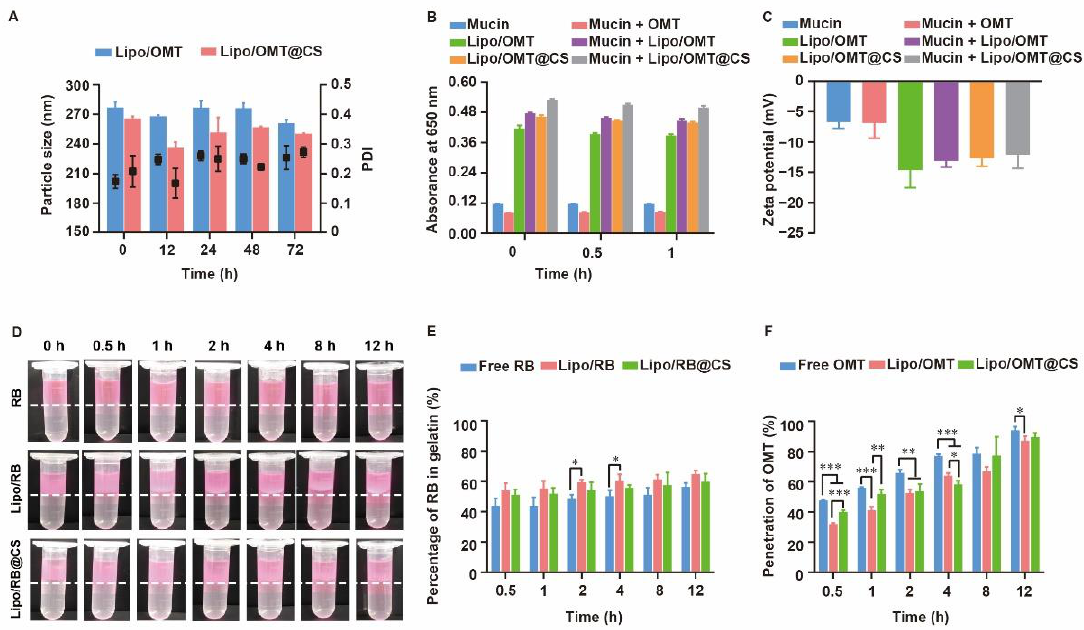
Figure 4. Stability and penetration capability of OMT/RB liposomal preparations in mucin media. ( A ) Particle size of OMT liposomal preparations in mucin. ( B ) Absorbance at 650 nm and ( C ) zeta potential of OMT liposomal preparations alone or in a mucin solution. ( D ) Visual observation of RB liposomes penetrations through the mucin layer at different time point (dotted line indicated the interface between mucin and gelatin layer). ( E ) The percentage of RB in gelatin layer. ( F ) Penetration percentage of OMT through mucin layer in transwells. All the data were expressed as mean + SD ( n = 3). * p < 0.05, ** p < 0.01, *** p < 0.001.